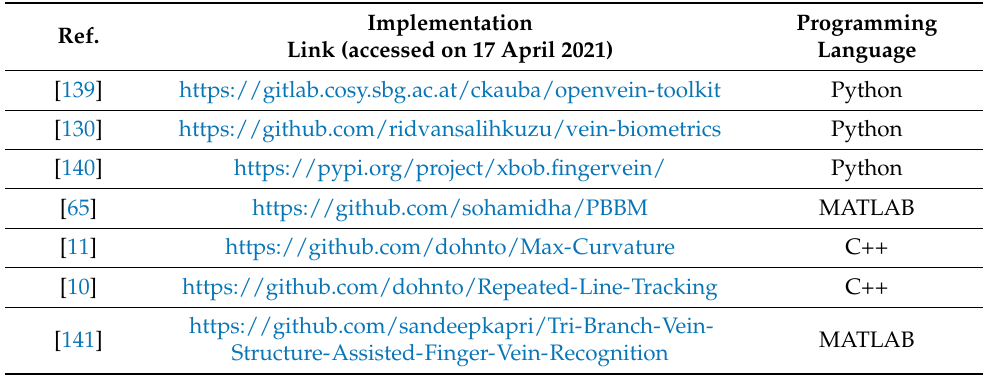
Table 8. Some available software